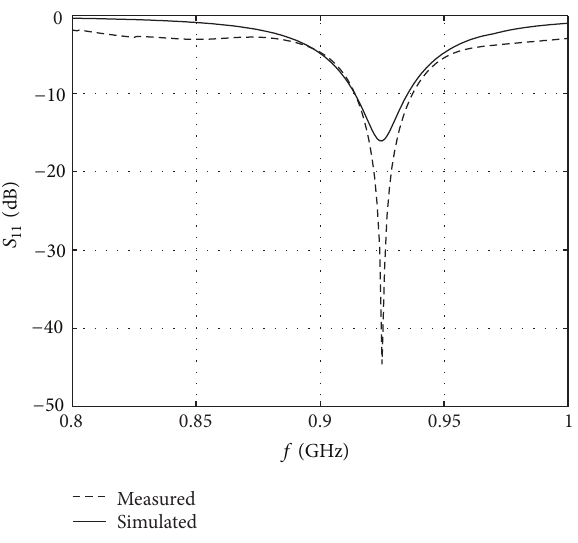
Figure 4: Simulated and measured 𝑆 11 of the